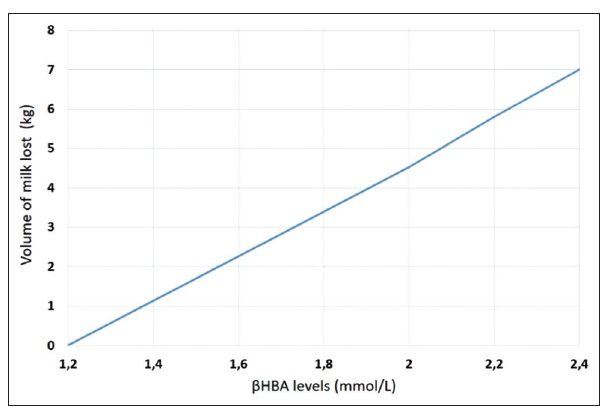
Figure 5: Impact of subclinical ketosis on milk production in dairy cows (own elaboration based on Oetzel